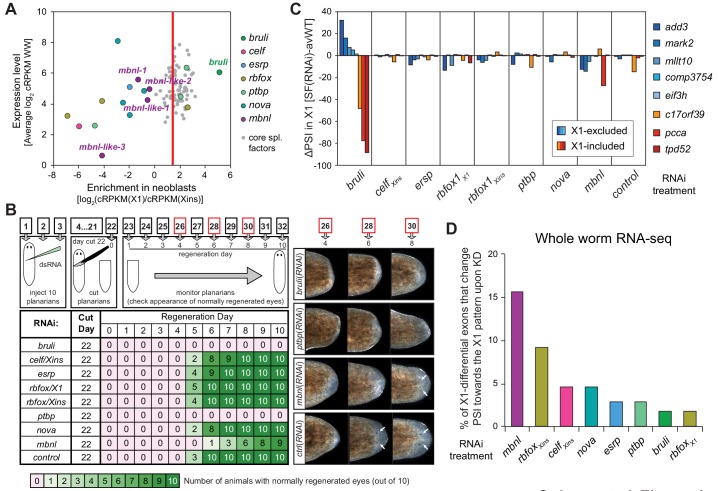
Identification of bruli and mbnl as major regulators of neoblast-specific AS.(A) Scattered plot highlighting differential gene expression for selected tissue-specific AS factors in planarians. X-axis: differential gene expression in X1 vs Xins cell fractions for selected AS factors (color dots) and core spliceosomal components (grey dots). The red line is the median enrichment value for the core spliceosomal components. An AS factor is thus considered to be enriched in X1 or Xins fractions if it is located to the right or to the left of this line, respectively. Y-axis: gene expression levels in whole worms (WW), using the cRPKM metric. (B) Test of regeneration speed after head ablation upon AS factor knockdown. Identification of normally looking eyespots was used as proxy for complete regeneration for 10 individuals per experimental condition. (C) ΔPSI estimates in X1 cell fractions by RT-PCR for two X1-included exons (red), one X1-included retained intron (c17orf39, orange) and five X1-excluded exons (blue) 10 days after RNAi treatment with dsRNA coding for AS factor combinations. ΔPSI values for each event and experiment are calculated respect to the average PSIs in three wild type samples. (D) Percent of neoblast-differential exons with sufficient read coverage that change their inclusion levels (ΔPSI ≥ 15) in whole worms towards the X1 pattern (as expected for a negative regulator of neoblast-differential AS) upon knockdown of each AS factor.DOI:
http://dx.doi.org/10.7554/eLife.16797.01410.7554/eLife.16797.015Figure 4—source data 1.Annotation of RBPs in planarians.DOI:
http://dx.doi.org/10.7554/eLife.16797.01510.7554/eLife.16797.016Figure 4—source data 2.Annotation of spliceosomal components in planarians.DOI:
http://dx.doi.org/10.7554/eLife.16797.01610.7554/eLife.16797.017Figure 4—source data 3.Single and multiple splicing factor knockdown RNAi groups.